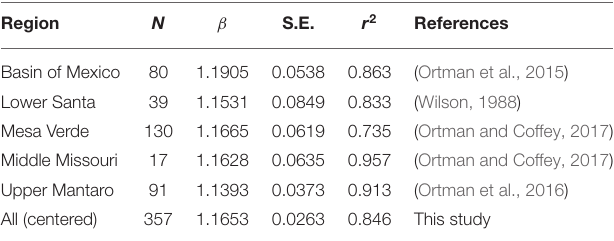
both population and total domestic roofed area at every site. TABLE 1 | Estimated scaling coefficients for the relationship between settlement population and total house area in five New World